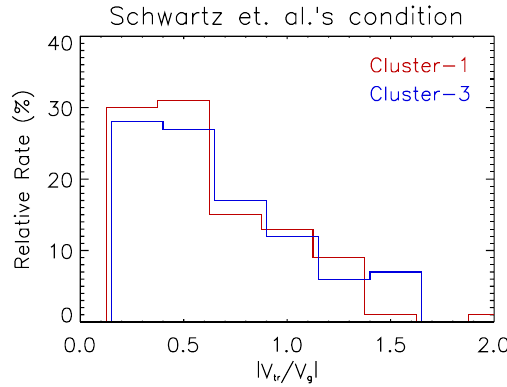
Fig. 12. The distribution of the rate given by Eq. (2). We use both Cluster SC1 and SC3 CIS HIA measurements to determine the nec- essary vectors in the formula. The red and blue lines show the dis- tribution based on Cluster-1 and -3